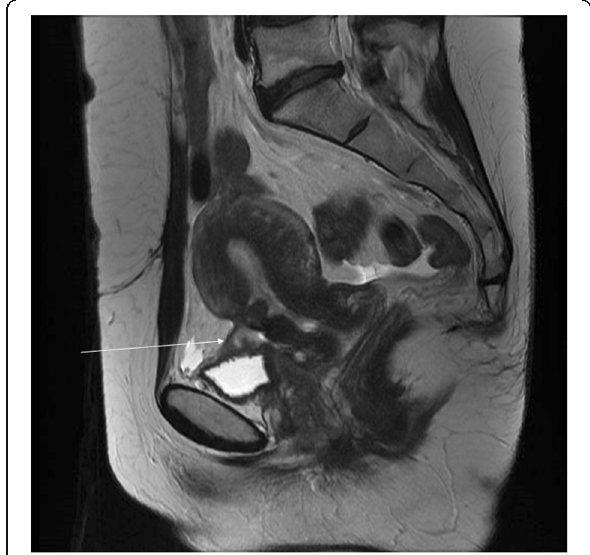
Fig. 8 The same patient as in Fig. 5. The arrow points at